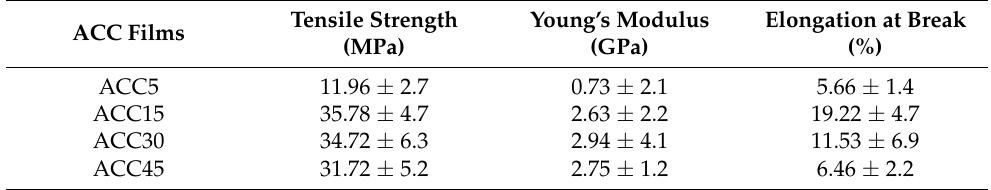
Table 2. Mechanical properties of the all-cellulose composite films prepared at different dissolution